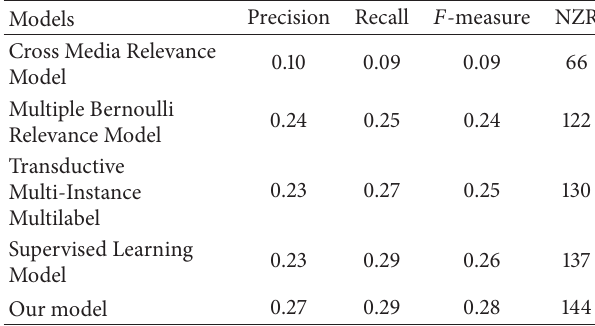
Table 2: Experimental